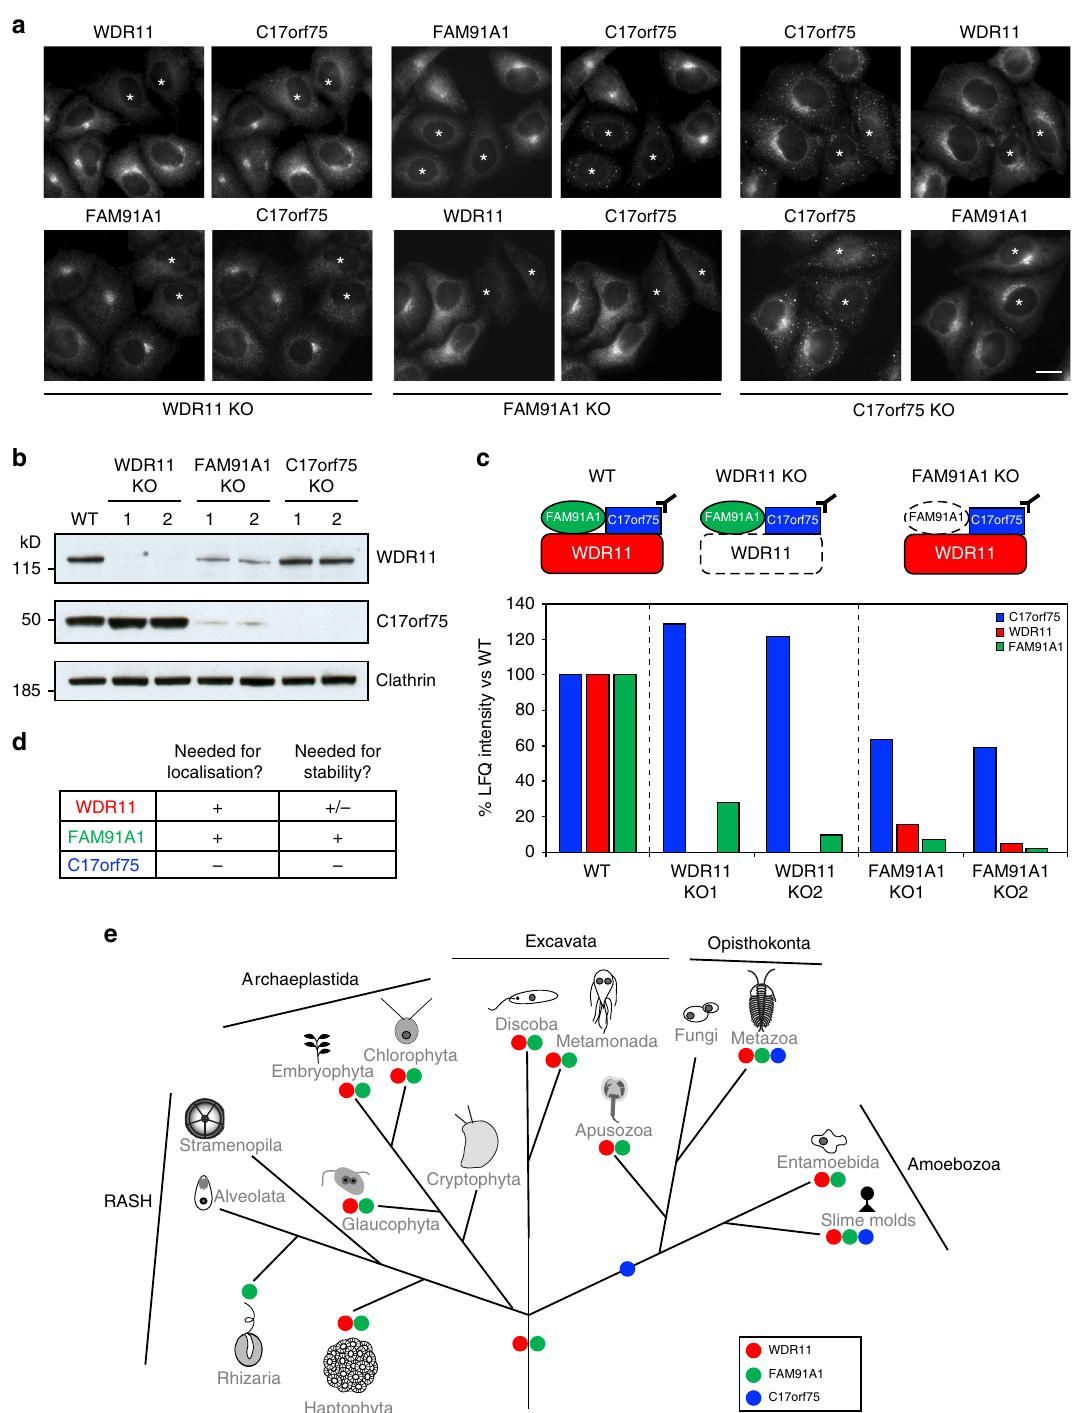
Fig. 3 Interdependence of the subunits of the WDR11 complex. a The WDR11, FAM91A1 and C17orf75 genes were independently knocked out, then double labelling was used to investigate the localisation of binding partners in mixed populations of wild-type and knockout (asterisks) cells. Scale bar: 20 µ m. b Western blots of wild-type and knockout cells were probed with antibodies against WDR11, C17orf75 and (as a loading control) clathrin heavy chain. The WDR11 blot is the same one shown in Fig. 1b. c C17orf75 and associated proteins were immunoprecipitated from wild-type, WDR11-disrupted and FAM91A1-disrupted cell lysates and analysed by mass spectrometry. In addition to revealing changes in protein stability and/or interactions, the data show that the FAM91A1 disruption was not a true knockout. d Summary of the results of a , b and c . e Eukaryotic tree of life showing the inferred point of origin of the genes encoding the three subunits, and which proteins are present in various modern